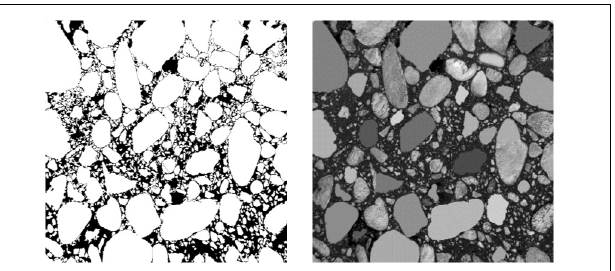
FIGURE 3 | Binarization of cross-section